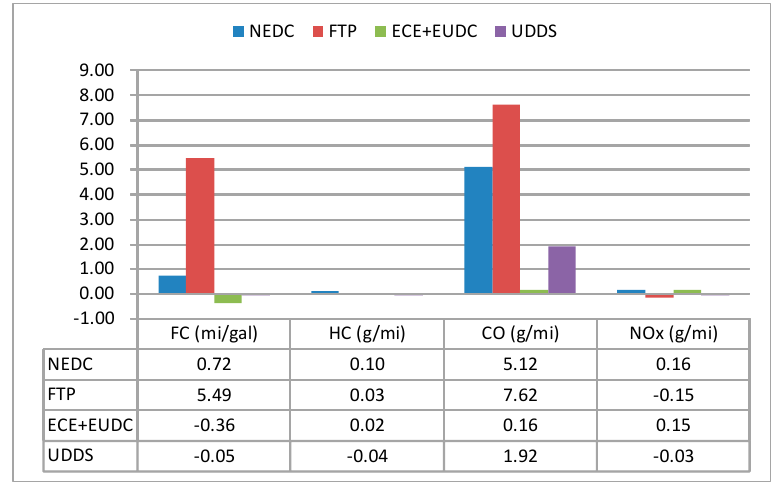
Figure 11. The histogram of the improvements in FC and emissions between the results using initial and optimal values of the parameters of control